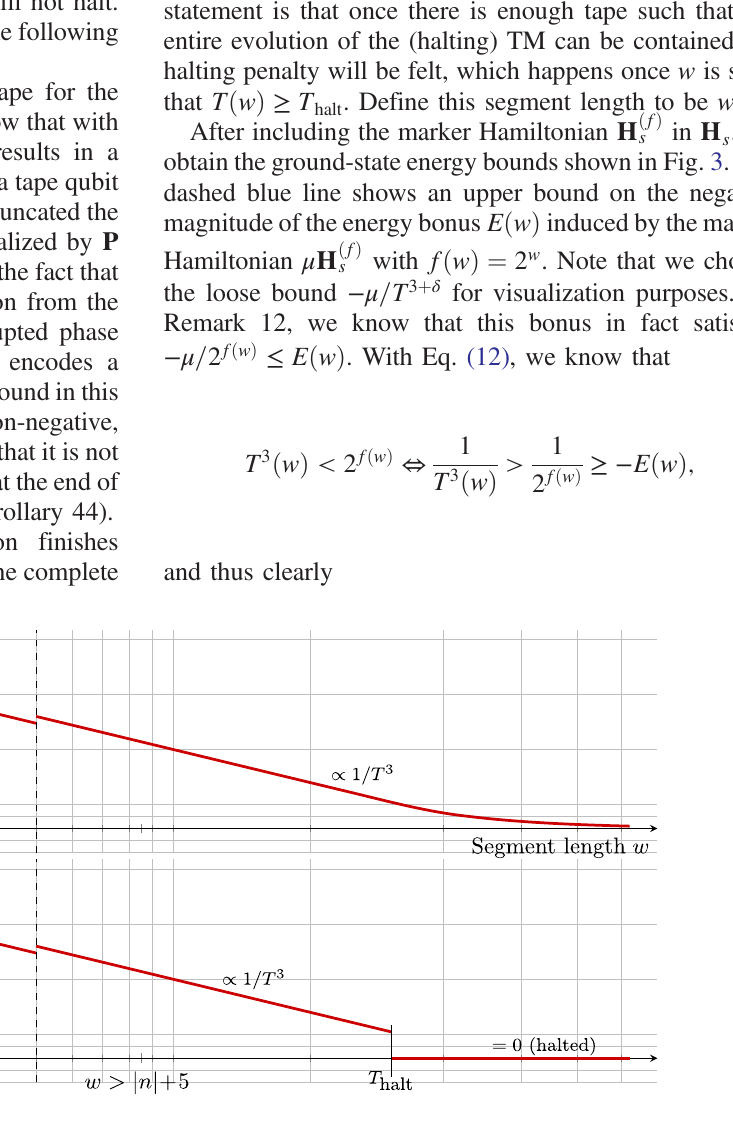
FIG. 7. Lower bounds to the ground-state energy of the QTM history state Hamiltonian on a single segment, as a function of the segment length, in the halting and nonhalting